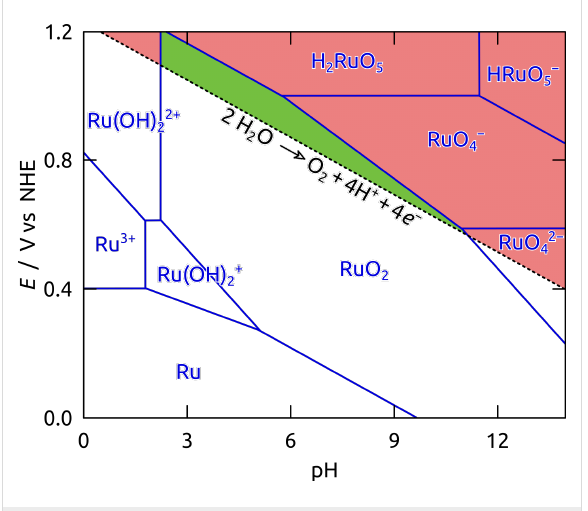
Figure 2: Pourbaix diagram for ruthenium in the presence of water (adapted from the Atlas of Eh-pH diagrams, Intercomparison of thermodynamic databases, Geological Survey of Japan Open File Report No.419) [12]. The limited thermodynamic stability of Ru is illus- trated for positive potentials E in the range of 0 ≤ pH ≤ 14 (blue lines) with the corresponding pH-dependent equilibrium potential for the water oxidation reaction (black dotted line). Regions of predominant thermodynamic stability and dissolution of the solid in water oxidation conditions are color-coded in green and red,